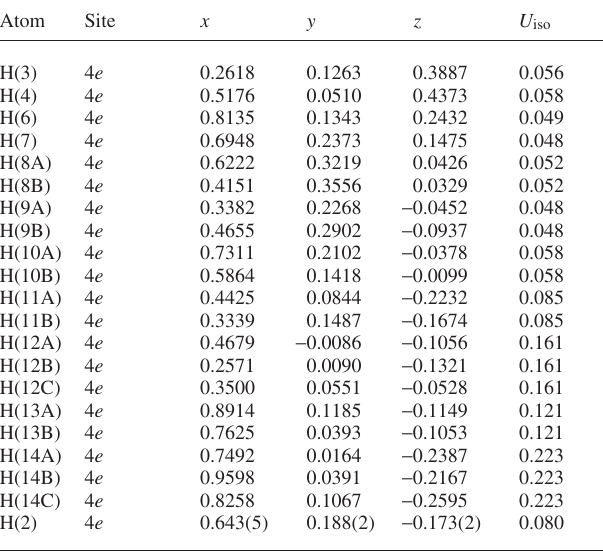
Table 2. Atomic coordinates and displacement parameters (in Å 2 )